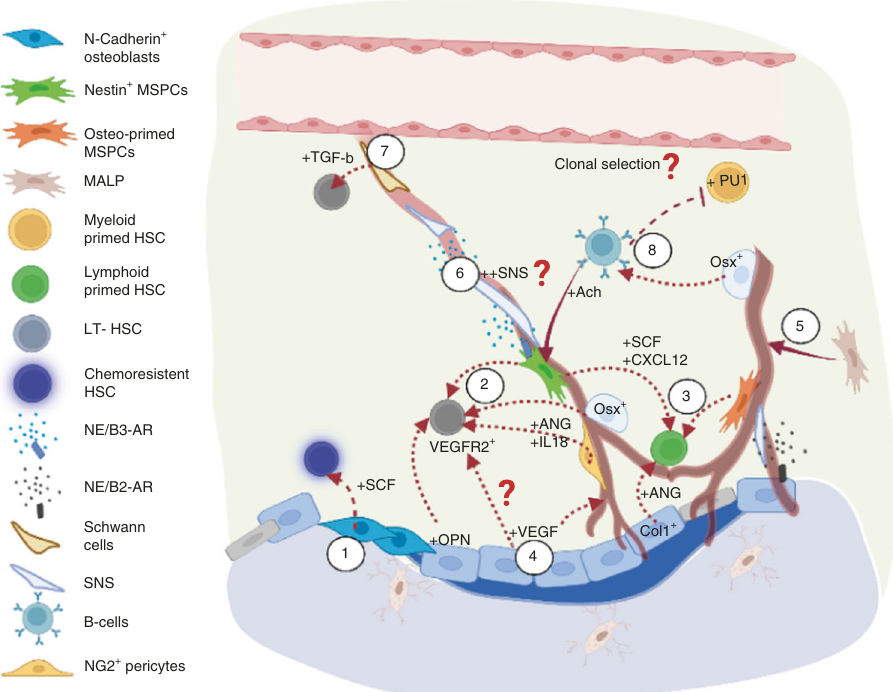
Fig. 3 Factors involved in the bone formation stage and their crosstalk with the hematopoietic compartment. (1) N-cadherin + osteoblasts have been shown to be spatially associated with chemoresistant HSCs via SCF regulation. (2) Osteolineage cells maintain phenotypic LT-HSCs via IL-18 and Nestin + /Osterix + /NG2 + cell-derived angiogenin (ANG). (3) In contrast, angiogenin from mature osteoblasts and LepR + / osteolectin + osteo-committed MSPCs maintain lymphoid-primed HSCs and common lymphoid progenitors. Periarteriolar Nestin + stromal cells secrete SCF and CXCL12 to maintain lymphoid primed or unbiased HSCs. (4) Osteogenesis impacts the bone marrow microenvironment in several ways. Osteoblast-derived VEGF boosts angiogenesis via VEGFR2, which also promotes the repopulating capacity of HSCs. (5) In addition, osteogenesis is associated with the enrichment of the arteriole-connecting capillaries (Type H vessels), which has been shown to be associated with MALP and Osterix + populations. (6) Moreover, the SNS has been found to be spatially associated with arterioles, which can enhance Nestin + MSPC-derived CXCL12 secretion through the action of β 3-adrenergic receptors and modulate cell motility following circadian cycles. (7) Schwann cells on nerve axons also contribute to HSC quiescence by activating latent TGF- β . (8) During bone formation, Osterix + osteoprogenitors and osteoblasts are critical for B lymphopoiesis, and pro-B cells secrete acetylcholine to retain HSCs/HSPCs in the bone marrow and suppress the expansion of myeloid cell progenitors. Several questions remain to be answered. For example, do different stages of bone remodeling affect perivascular stromal composition, cytokine gradient, and SNS regulation? Does bone remodeling also shape the spatial landscape of VEGF/VEGFR1 + (Fig. 2) and VEGF/VEGFR2 + signaling to regulate HSCs differently? Importantly, whether distinct hematopoietic clones exhibit speci fi c tropism toward a given microenvironment during bone remodeling/modeling cycles remains to be